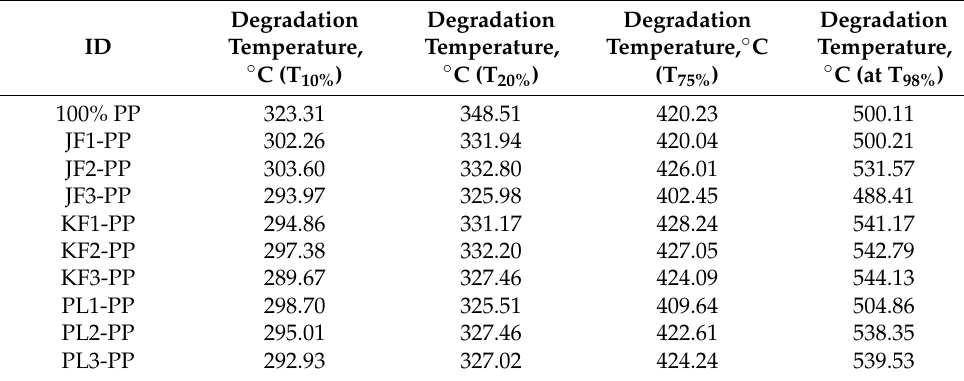
Table 4. TGA data of jute, kenaf and PALF-reinforced PP